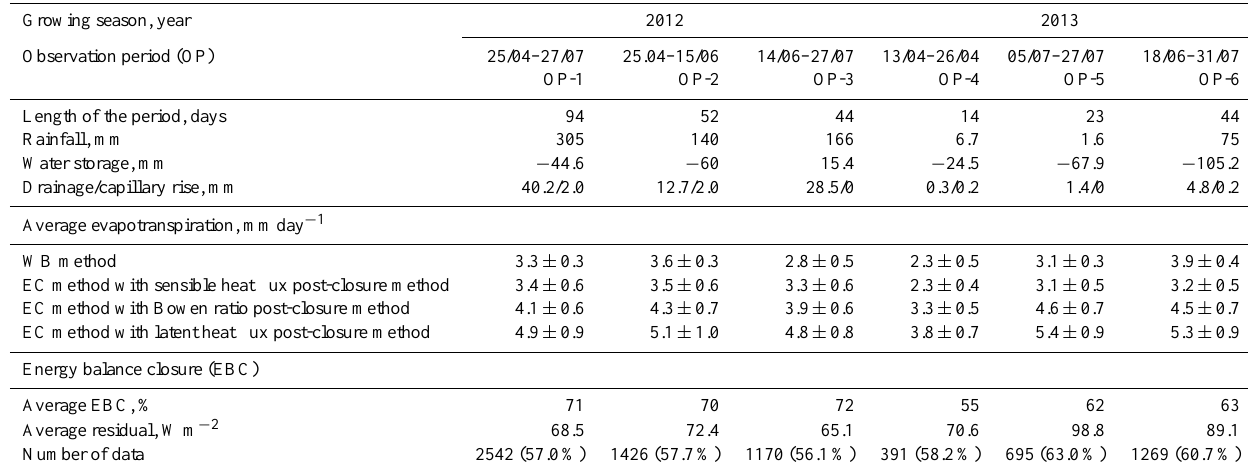
Table 3. Evapotranspiration measured with the water balance (WB) method and the eddy covariance (EC) technique at winter wheat stands in 2012 and